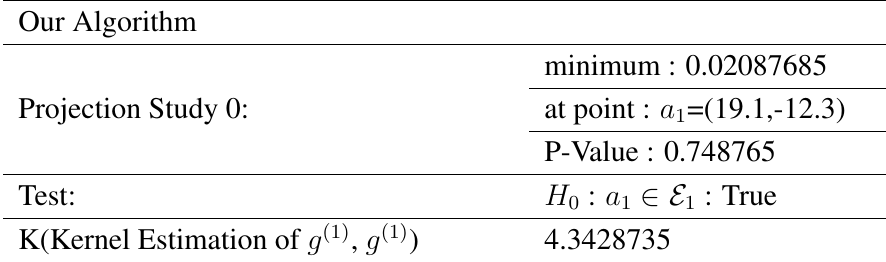
Table 5. Numerical results: First projection.